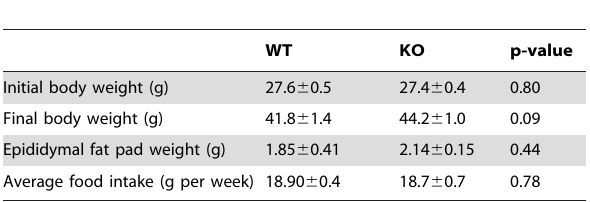
Table 1. Descriptive characteristics of WT and IL-6 2 / 2 mice fed a high fat diet (60% Kcals from fat) for 10 weeks (N =9–10/